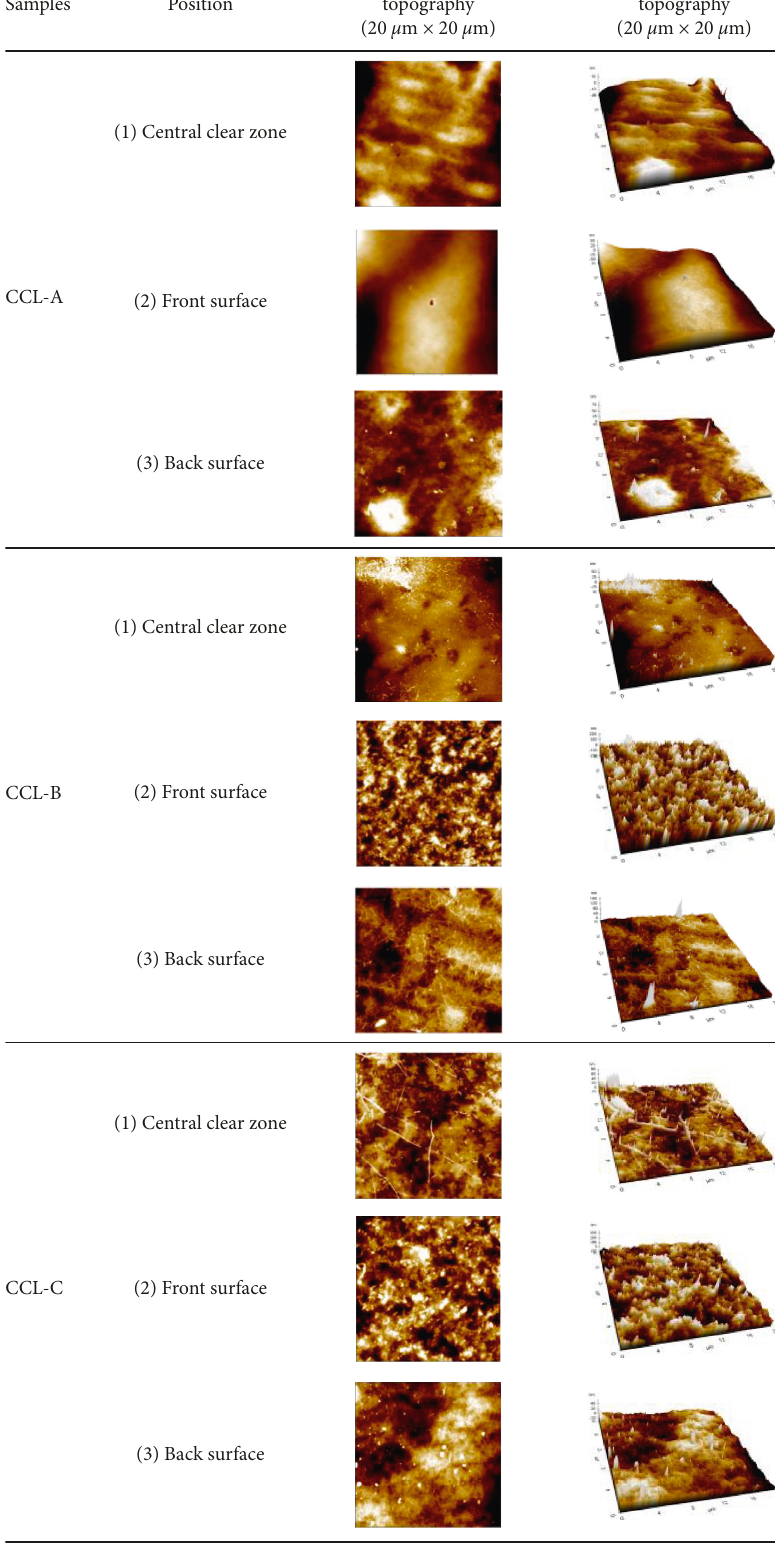
Figure 2: Comparison of surface topographies in images (20 μ m × 20 μ m) measured by